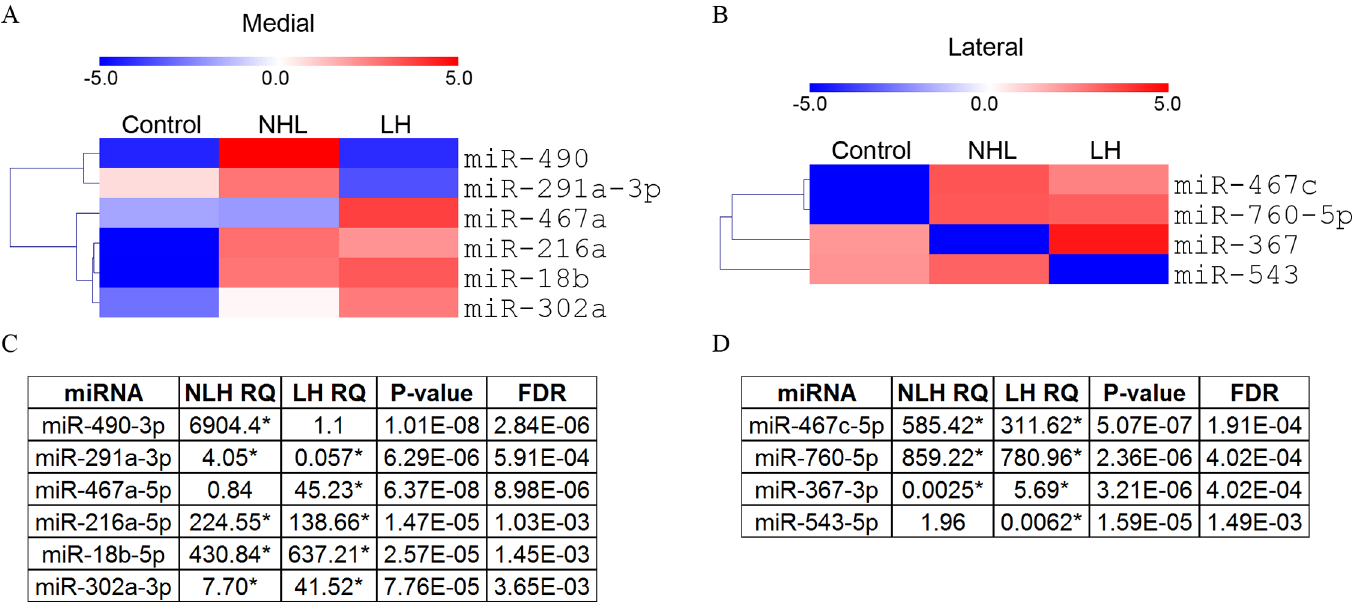
Fig 4. Differential miRNA expression. A+C) miRNAs exhibiting significant expression changes in MHb are depicted in a heatmap (A) and relative quantity (RQ) compared to control, ANOVA p-value and FDR are shown in a table (C). B+D) miRNAs exhibiting significant expression changes in LHb are depicted in a heatmap (B) and relative quantity (RQ) compared to control, ANOVA p-value and FDR are shown in a table (D). (See supporting S1 Table for all expressed miRNAs). Significance, indicated by * was found by Benjamini-Hochberg corrected ANOVA (FDR < 0.05) with Tukey post hoc test. Colors represent mean centered, negative Ct values. LH: Rats becoming helpless under the learned helplessness paradigm. NLH: Rats resistant to the learned helplessness paradigm.